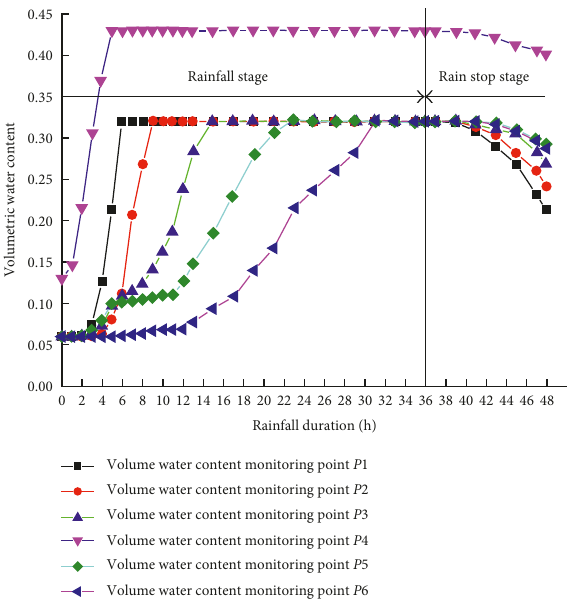
Figure 6: Variation law of volumetric water content with rainfall duration under long-time heavy rain.